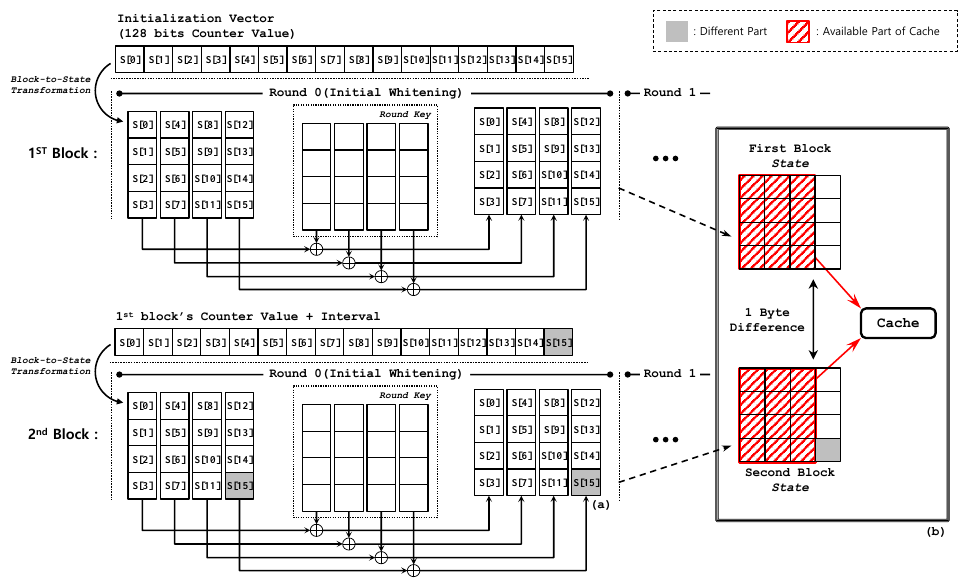
Figure 3: FACE rd 0 : AES initial whitening (round 0) of the first block and the second block in CTR mode. (a) shows the 1 byte difference between rout the cached part used by FACE